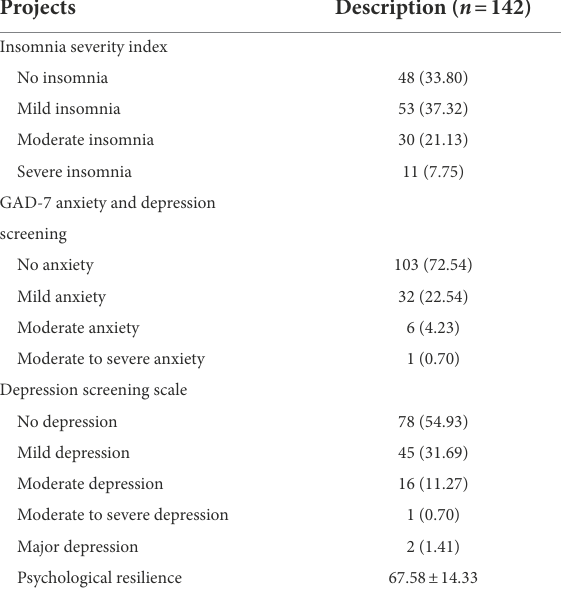
TABLE 7 Distribution of insomnia, anxiety, and depression among frontline medical